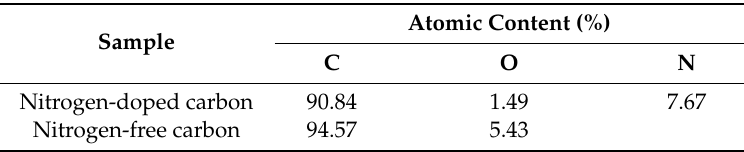
Table 1. The carbon, oxygen and nitrogen atomic contents (%) of nitrogen-doped carbon and nitrogen-free carbon determined by elemental analysis.